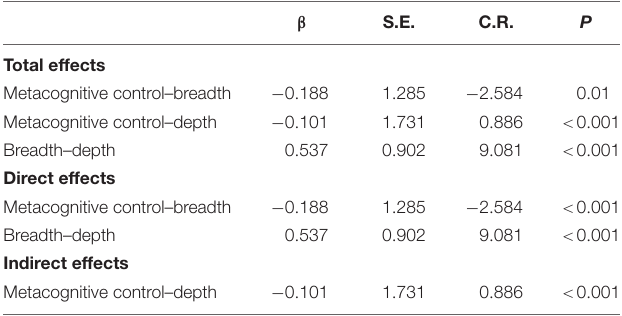
TABLE 4 | Path coefficients of self-regulation and vocabulary knowledge.